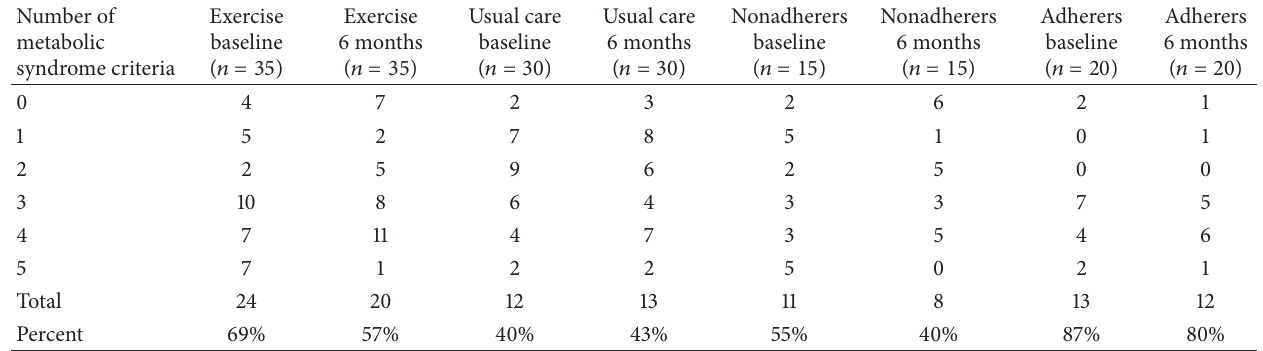
Table 2: Percent and number of participants defined as having the metabolic syndrome at baseline and six